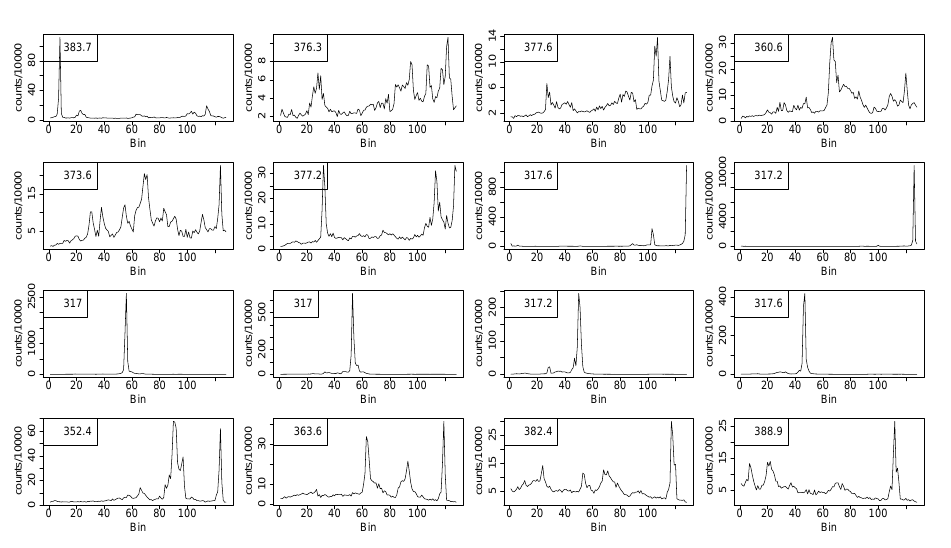
Figure A1. Waveform examples for the Canadian Lake Nonacho. The legend displays the retracked surface